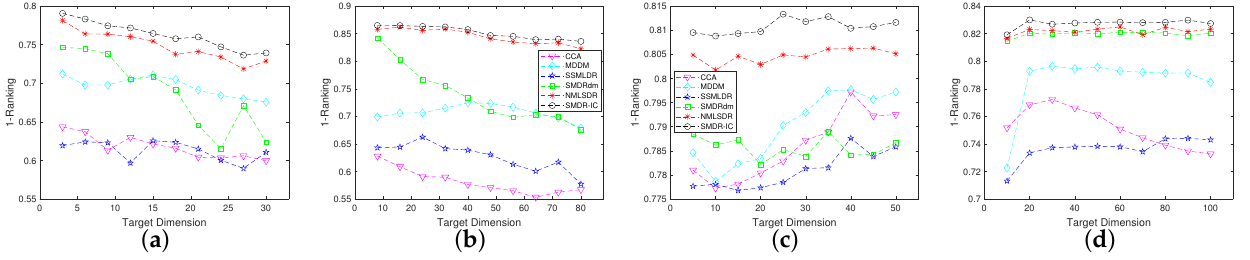
Figure 4. Results of 1-Ranking on four data sets under different target dimensionalities. ( a ) Emotions. ( b ) Scene. ( c ) Yeast. ( d ) Arts.